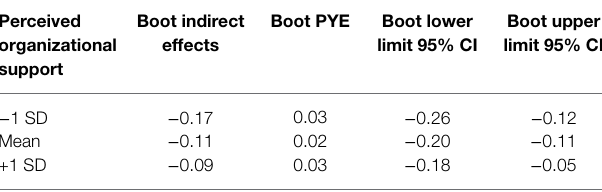
TABLE 5 | Bootstrap results for conditional indirect effects psychological empowerment.